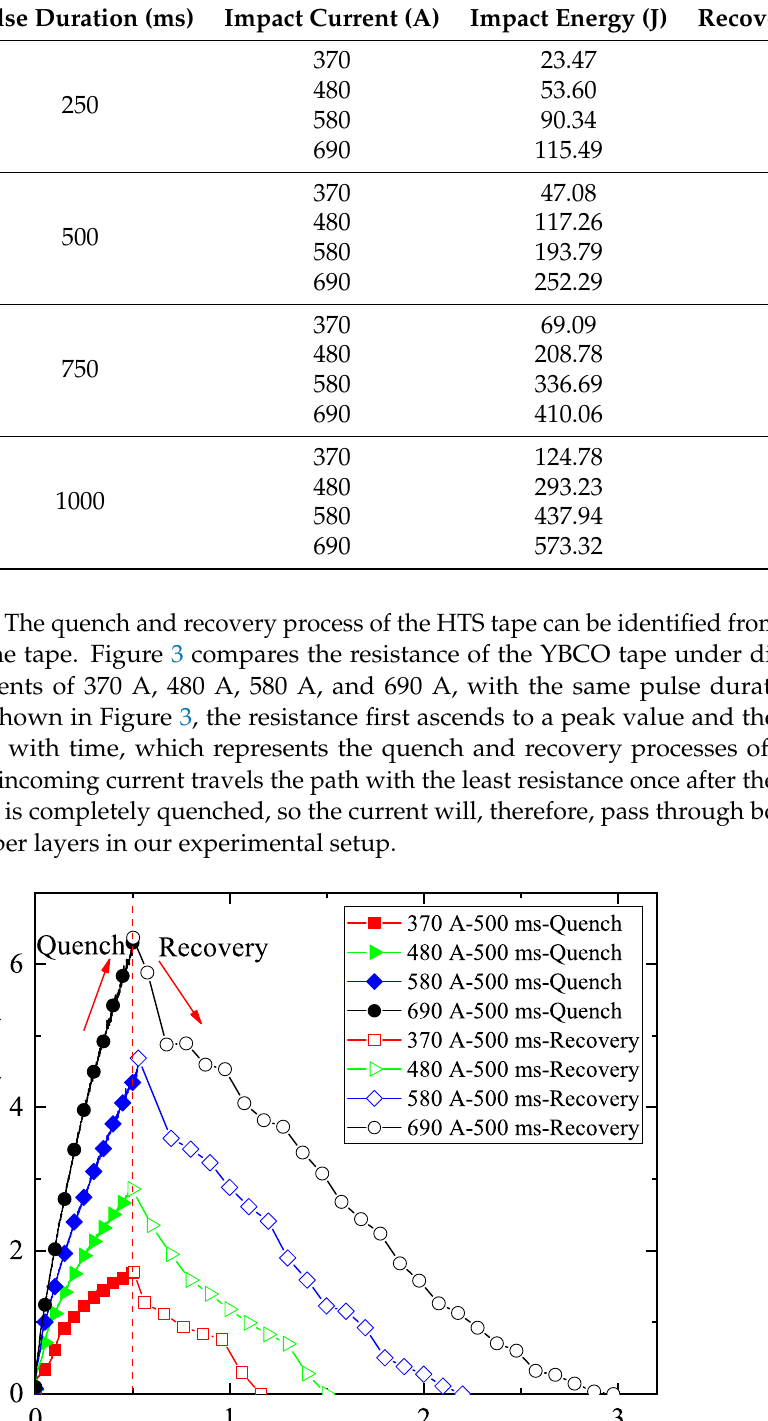
Table 2. Impact current, pulse duration, impact energy, and recovery time obtained in the experiments.